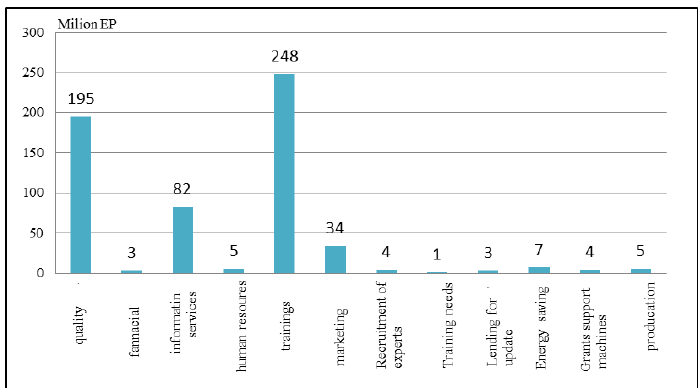
Figure 10. Technical Services provided bythe Industrial Modernization to Damietta furniture customers